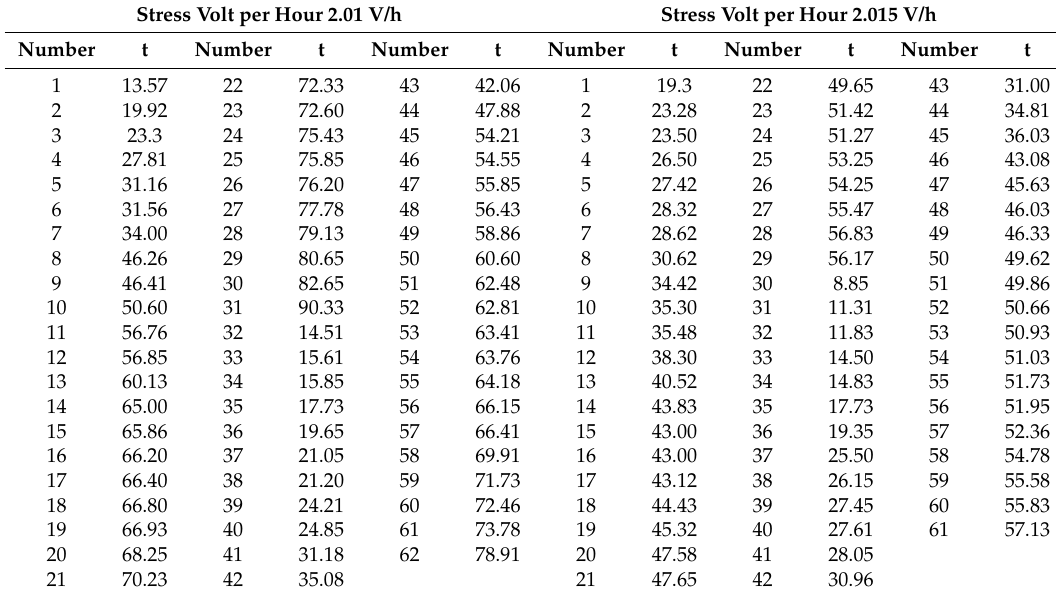
Table 1. Failure times of miniature light bulbs from ramp-voltage experiment.